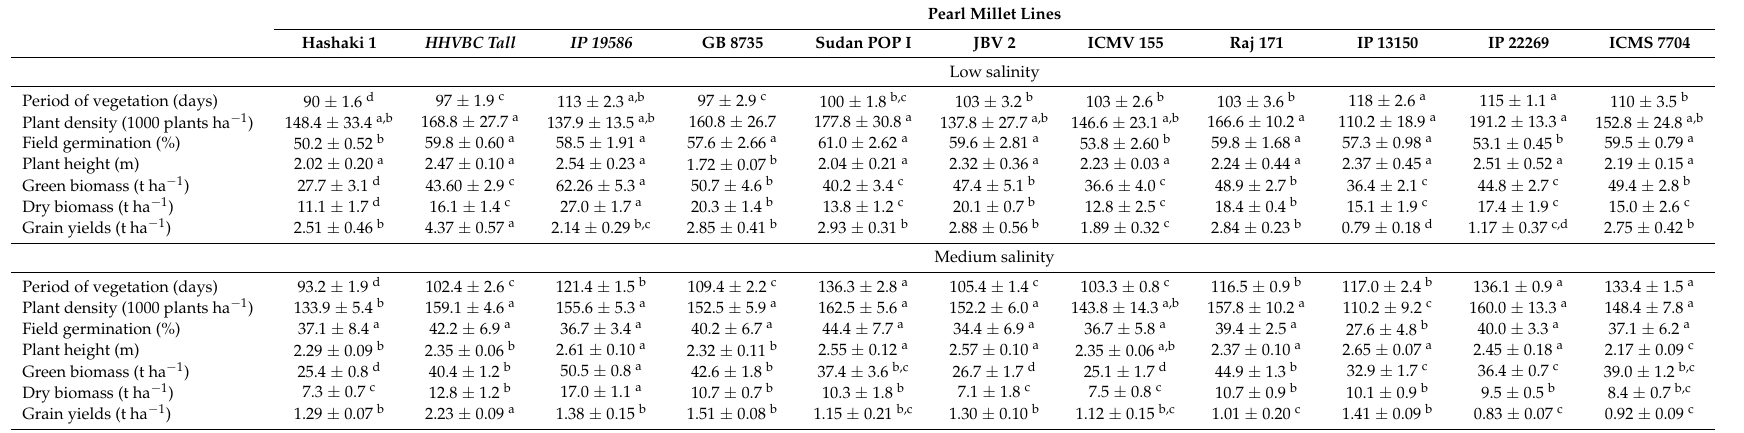
Table 1. Impact of soil salinity on agrobiological characteristics, green/dry biomass and grain yield production of introduced of pearl millet Pennisetum glaucum improved genetic lines (average of filed data, Kazakhstan). Low salinity—EC 1.5–3.5 dS m − 1 ; medium salinity—EC 6–8 dS m − 1 . The values are means ± SEs. Different letters above the bars represent significant differences at the p < 0.05 level (Tukey’s pairwise